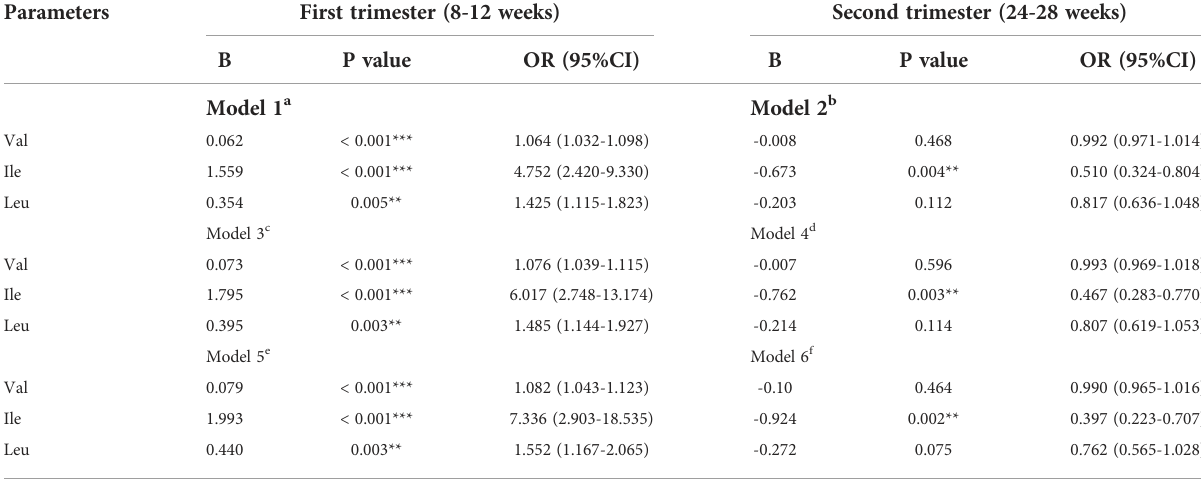
TABLE 4 Logistic regression analysis of the BCAAs in the fi rst and second trimesters associated with gestational diabetes mellitus (GDM).